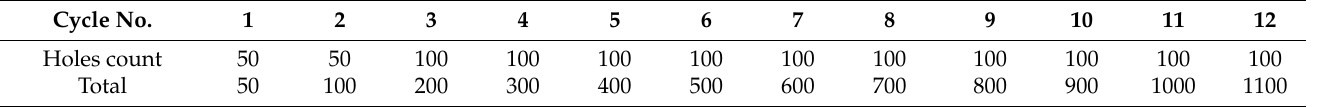
Table 3. Number of holes drilled in successive blunting cycles.